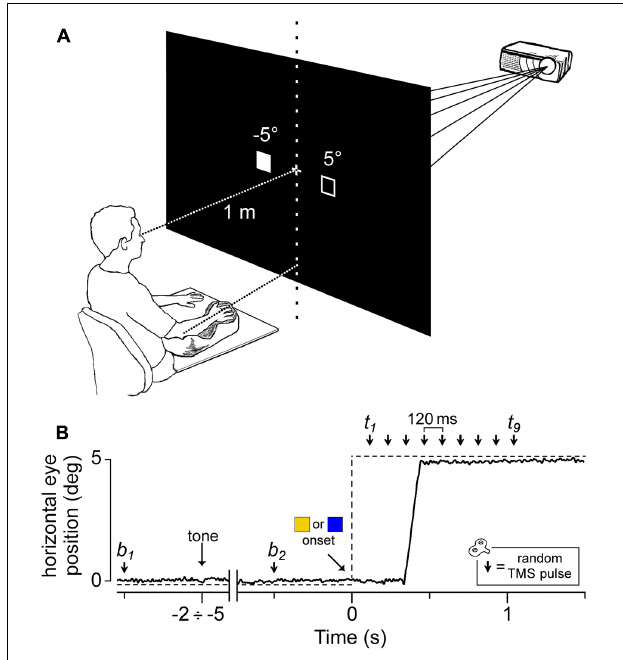
FIGURE 1 | Experimental setup and protocol. (A) Visual stimuli were rear-projected on a wide-tangent black screen placed 1 m in front of the subject. The filled square represents the actual location of the visual cue, while the empty square indicates the other possible position. The head was immobilized using a chin rest and a head-support device (not shown). Notice the arm-hand posture imposed on the subject with respect to the central vertical meridian (see text). (B) An EOG recording (solid line) during a representative saccadic response. The dashed line indicates the time course of the visual stimulation. The peripheral cue ( (cid:4) or (cid:4) ) appeared at a variable time interval of 2–5 s after a warning tone. A single pulse of TMS was randomly delivered either before cue onset (at b 1 or b 2 ) or at one of nine equally spaced time delays between 120 ms and 1080 ms ( t 1 – t 9